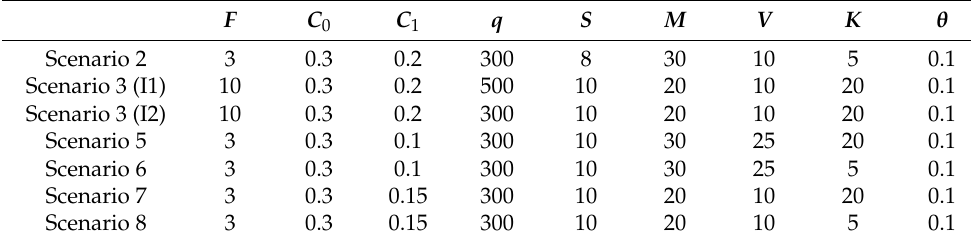
Table A1. Parameter settings for six initial